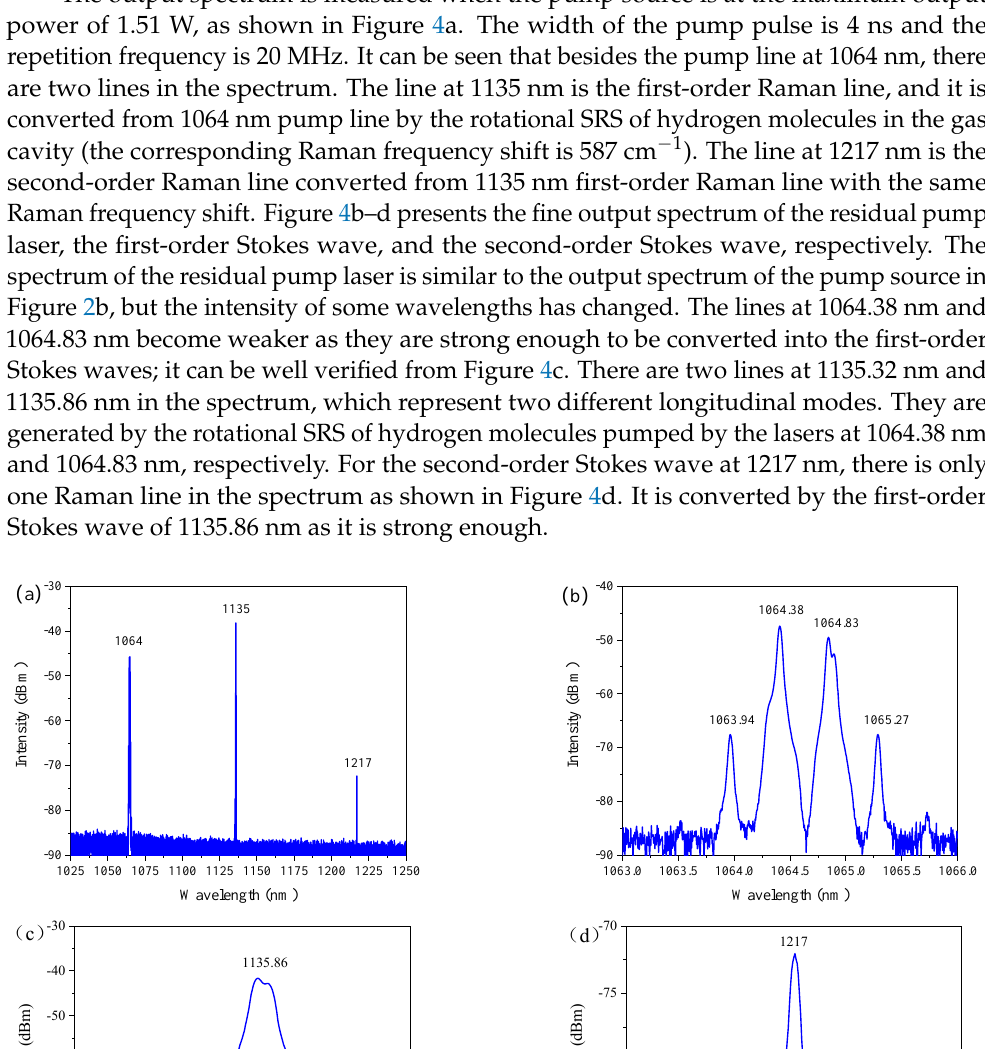
Figure 3. ( a ) The schematic cross section of the HC-PCF and ( b ) the transmission loss and dispersion curves of the HC- PCF, both from the product manual provided by NKT Photonics.